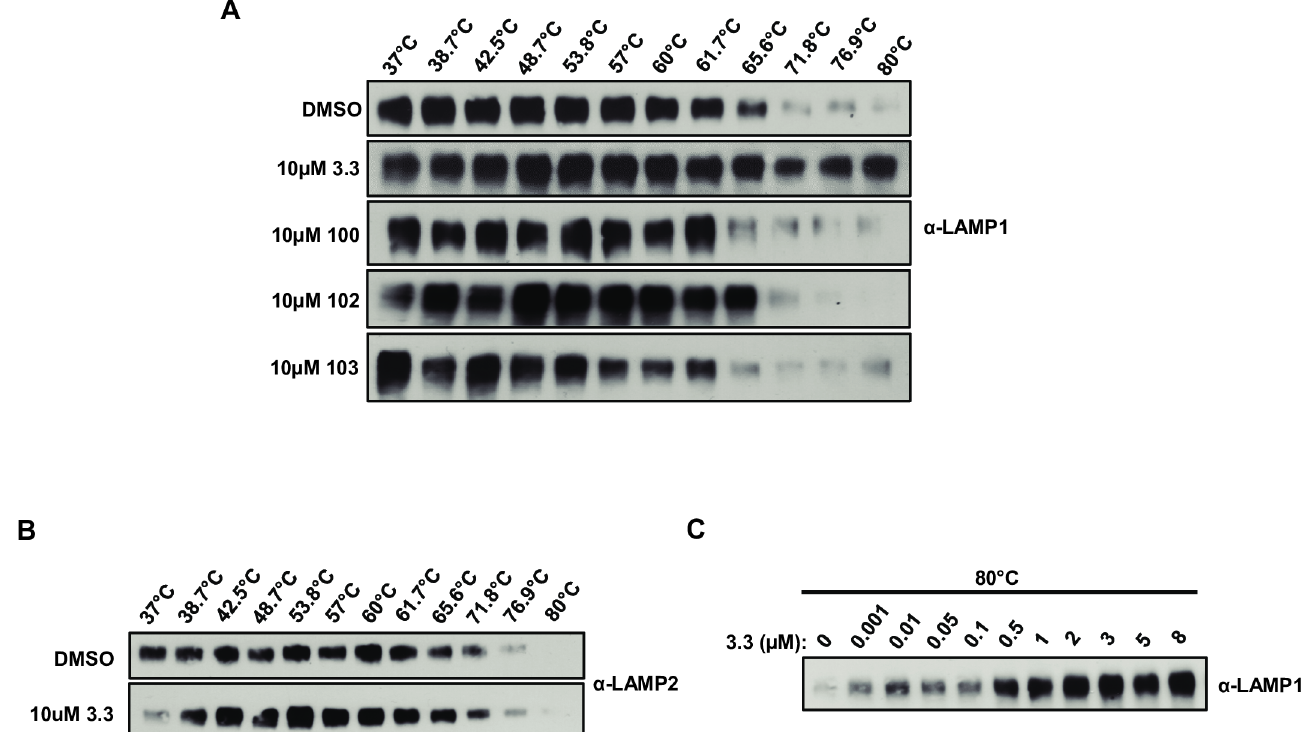
Fig 3. 3.3 protects LAMP1, but not LAMP2, from thermal denaturation in cells. (A) 3.3 but not the inactive derivatives, 100, 102 and 103, raises the T m of endogenous LAMP1. 293T cells were incubated with 10 μ M of the indicated compounds or DMSO for 1h at 37˚C. Cells were harvested and heated to the indicated temperatures prior to lysis. Lysed samples were centrifuged and the supernatants were analyzed by immunoblot with an anti-LAMP1 antibody. (B) 3.3 does not alter the thermal denaturation profile of endogenous LAMP2. 293T cells were incubated with 10 μ M 3.3 or DMSO for 1h at 37˚C. Cells were harvested and heated to the indicated temperatures prior to lysis. Lysed samples were centrifuged and the supernatants were analyzed by immunoblot with an anti-LAMP2 antibody. (C) 3.3 dose-dependently protects endogenous LAMP1 from thermal denaturation at 80˚C. 293T cells were incubated with the indicated concentrations of 3.3 or DMSO for 1h at 37˚C. Cells were harvested and heated to 80˚C prior to lysis. Lysed samples were centrifuged and the supernatants were analyzed by immunoblot with an anti-LAMP1